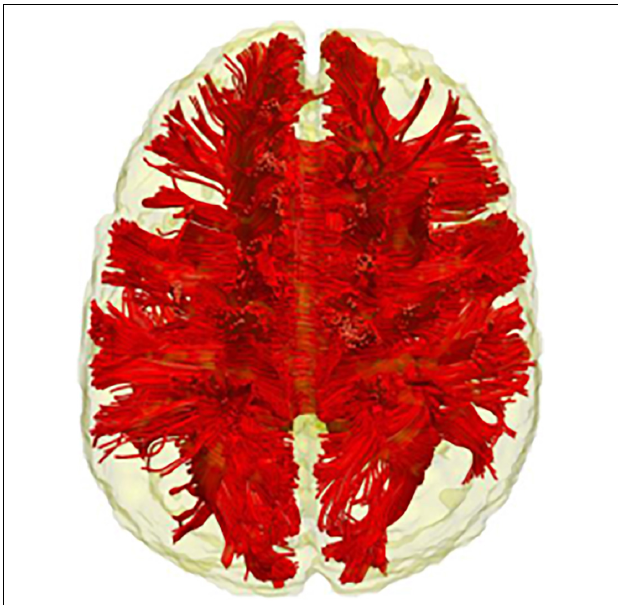
FIGURE 4 | The corpus callosum. Tractography representation of the corpus